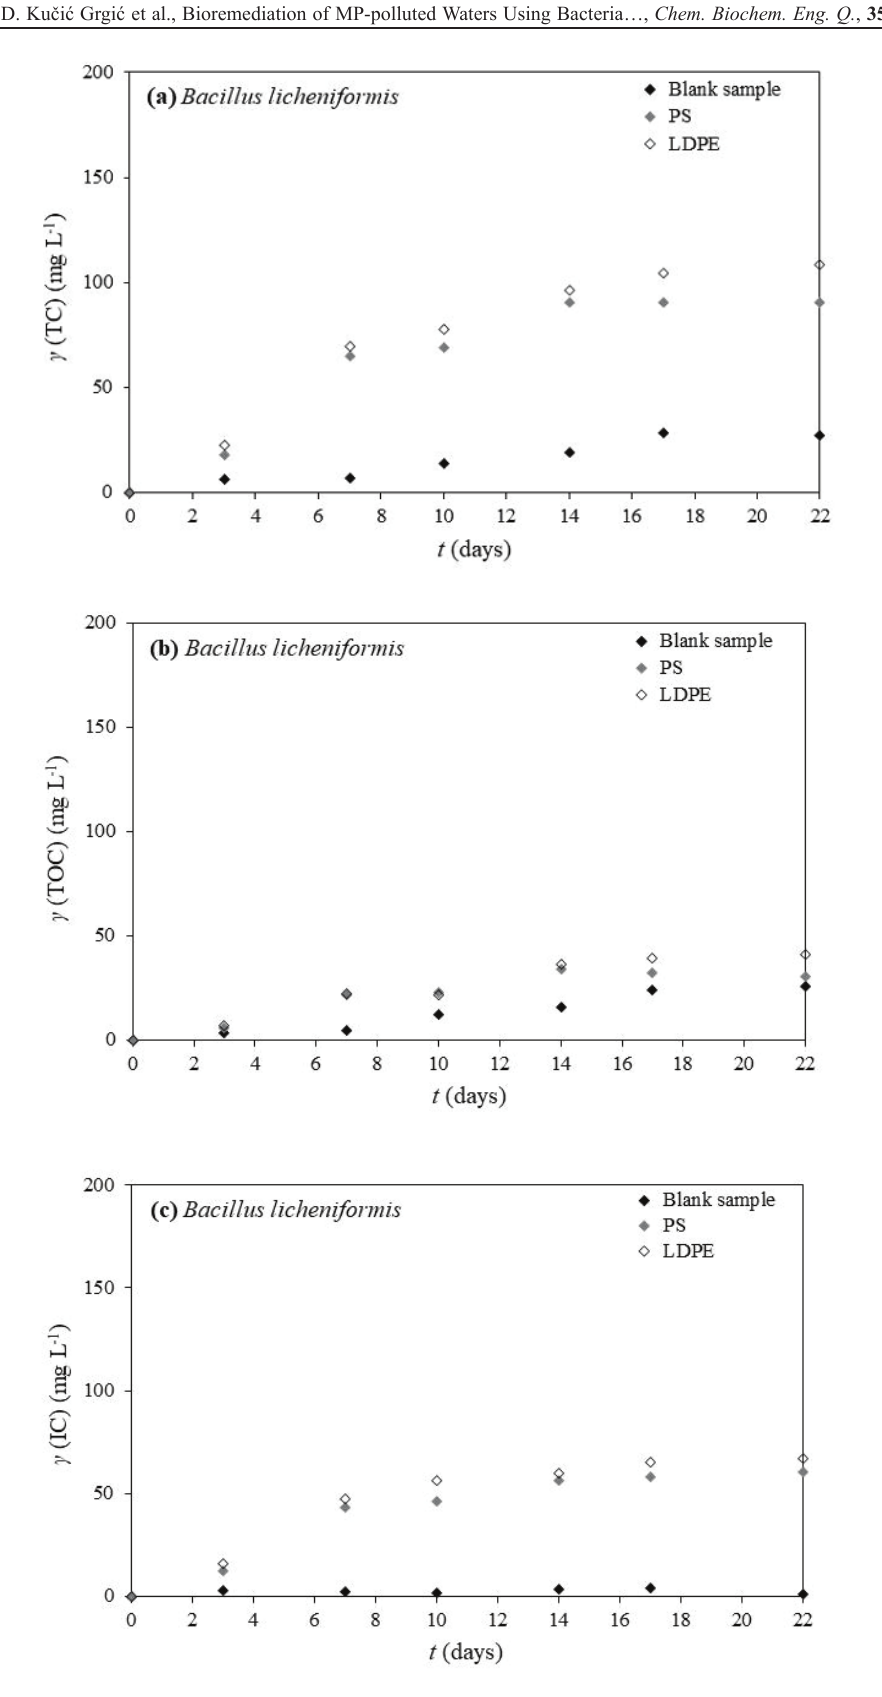
Fig. 5 – Changes in TC (a), TOC (b) and IC (c) concentration during biodegradation of MP-LDPE and MP-PS with bacterial culture Bacillus licheniformis in sterile Erlenmeyer flasks during 22 days (Vr = 100